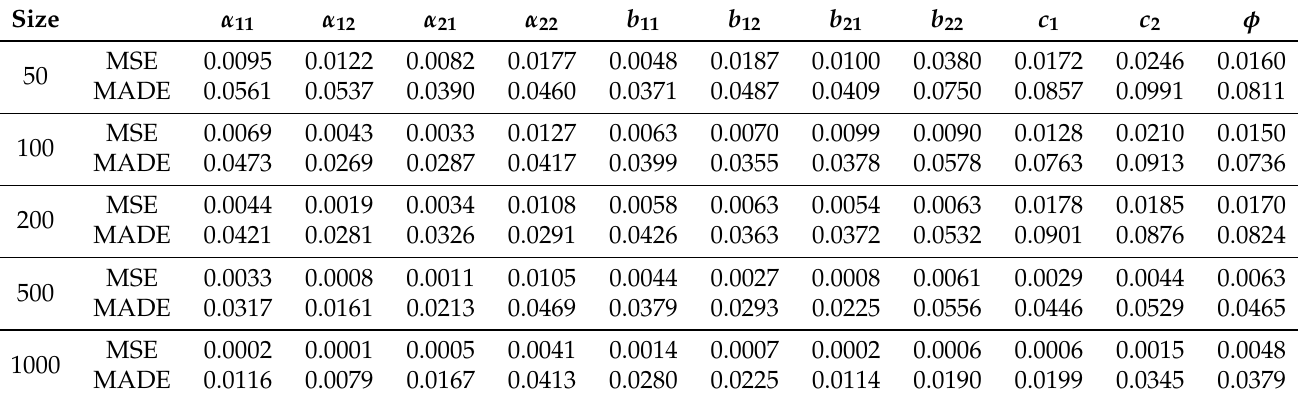
Table 1. Results for non-diagonal EBINAR(1) model.